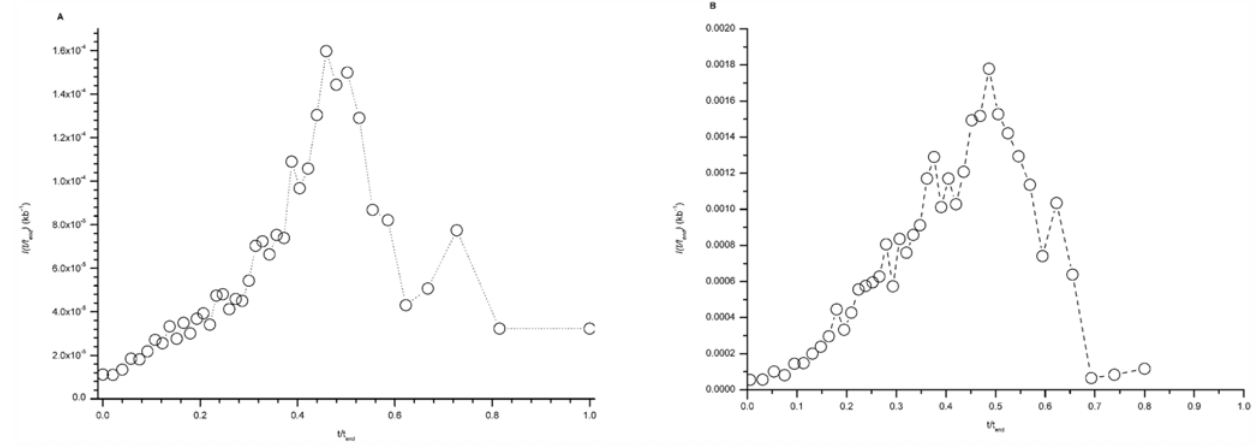
Figure 2. I(t) in Homosapiens . I(t) was determined from the replication timing profiles determined by Woodfine et al. [6,7] for: (A) the whole genome, at 1 Mb resolution [7] or (B) chromosome 6, at 94 kb resolution [6], as described in the Materials and Methods.